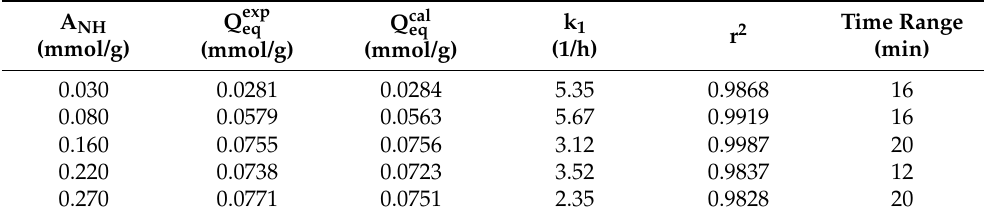
Table 2. The kinetic parameters calculated by the pseudo-first order model for adsorption of Cr(VI) ions on AEAPTES-silica beads with different amino groups in a 0.20 mM K 2 Cr 2 O 7 solution at pH 3.0 and 30 ◦ C.